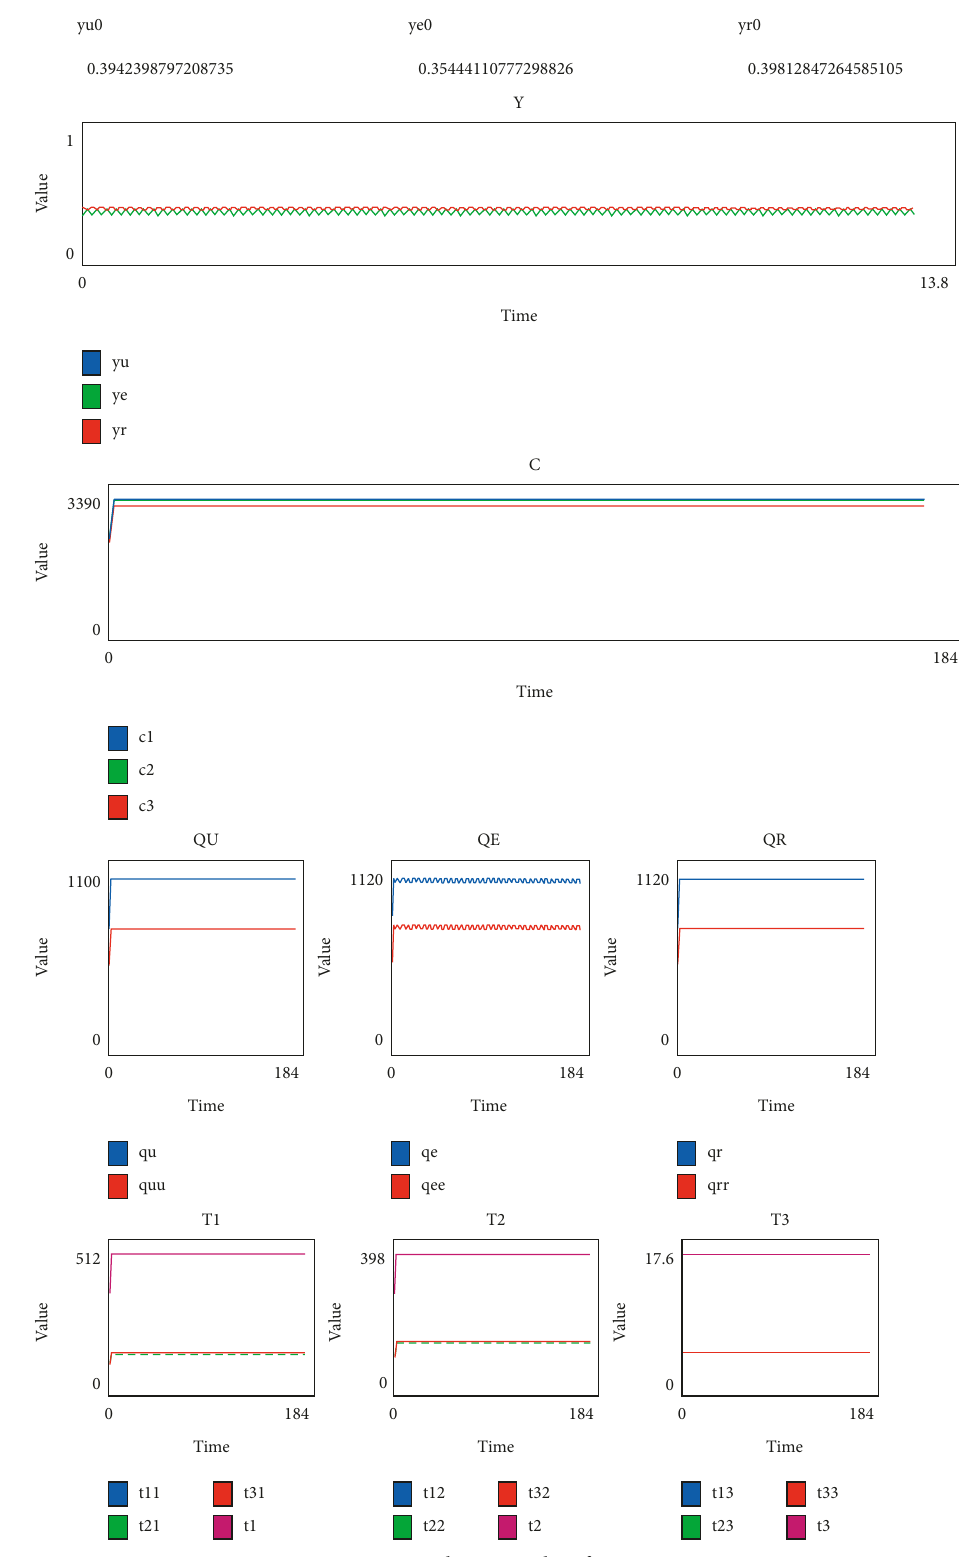
Figure 3: Simulation results of scenario